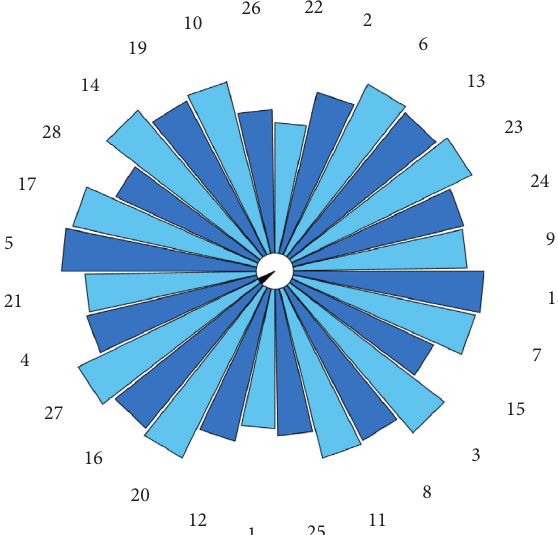
Figure 9: The assembly sequence diagram of blades.